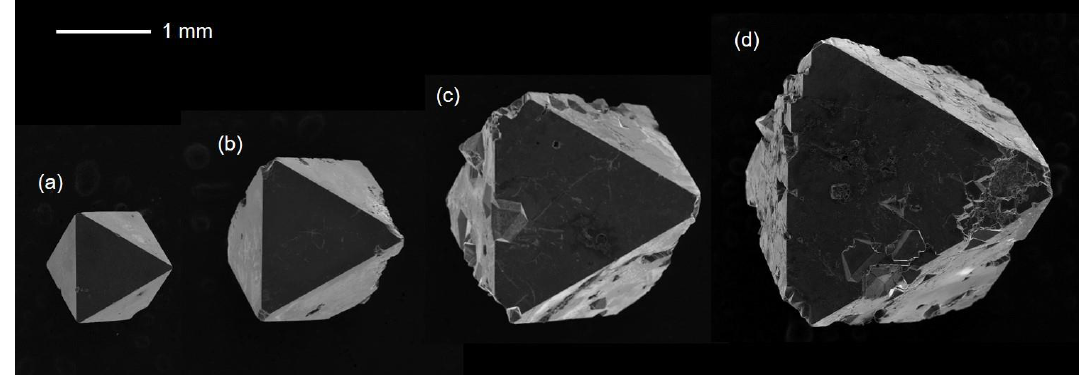
Figure 2. SEM images of ( a ) the seed crystal prepared by heating Na 4 Si 4 and Na 9 Sn 4 at 823 K for 12 h, seeded grown single crystals by heating at 823 K for the total heating time of ( b ) 12, ( c ) 24, and ( d ) 36 h.